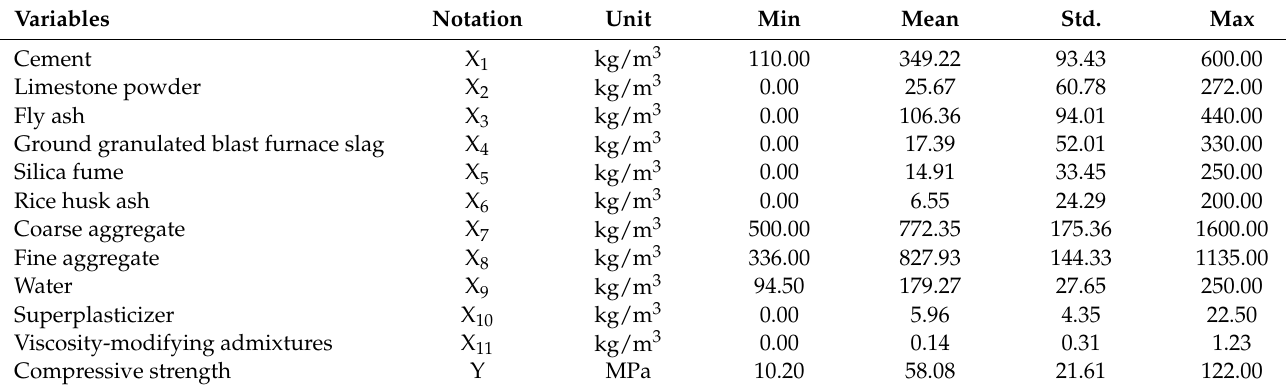
Table 2. The variables used in the Dataset